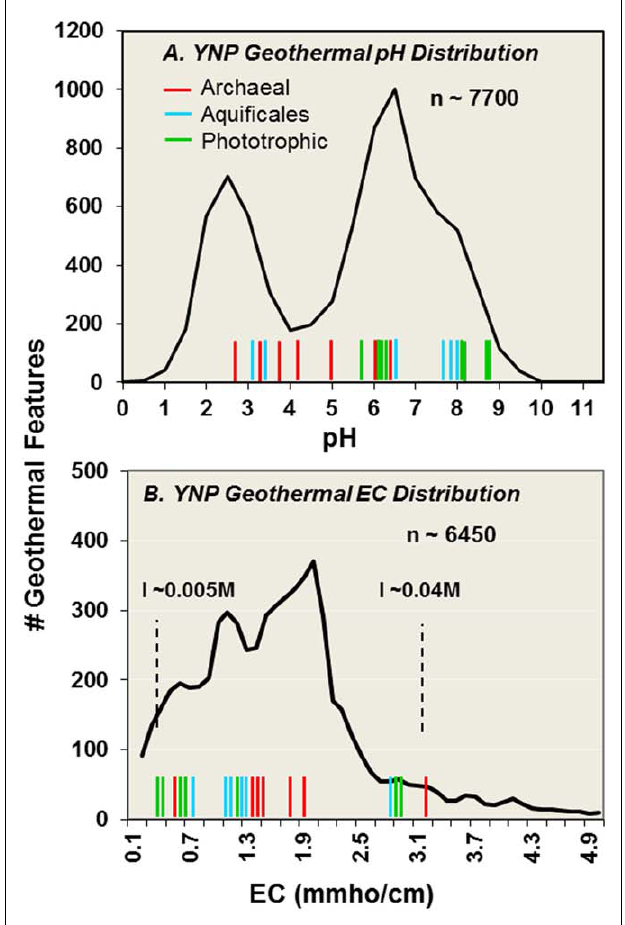
FIGURE 2 | Distribution of pH (A) and electrical conductivity (EC) (B) values across 7700 and 6450 geothermal features, respectively, cataloged in theYellowstone Center for Resources (YCR) database (available on line via www.rcn.montana.edu) .Vertical bars along pH and EC axes indicate values of the 20 sites described in the current study (Aquificales “streamer” communities = blue; archaeal-dominated sites = red; phototrophic mats = green). Ionic strengths ranging from ∼ 0.005–0.04M are indicated with dashed lines (WS_18 has the highest EC in the study of ∼